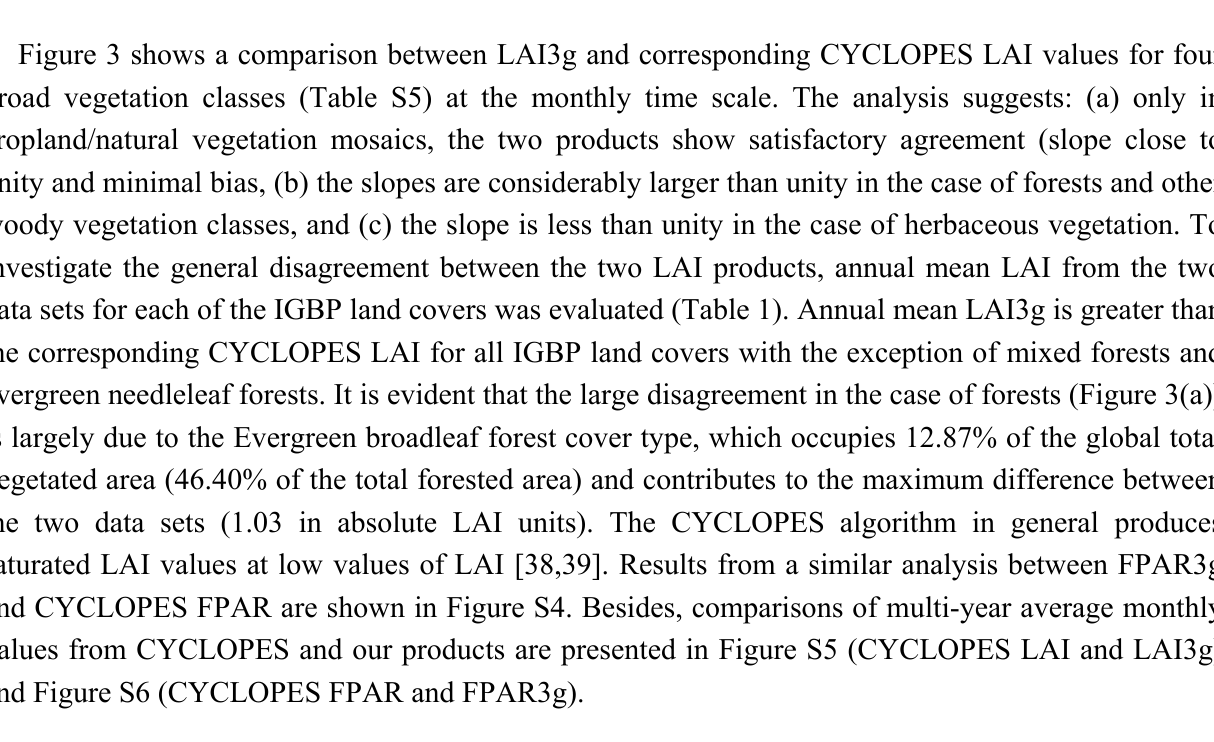
Figure 3. Comparison of monthly LAI values from CYCLOPES and LAI3g data sets for four broad vegetation classes (forests, herbaceous vegetation, other woody vegetation and cropland/natural vegetation mosaics) for the period 1999 to 2007. These classes are groups of International Geosphere Biosphere Programme (IGBP) land cover types as per Table